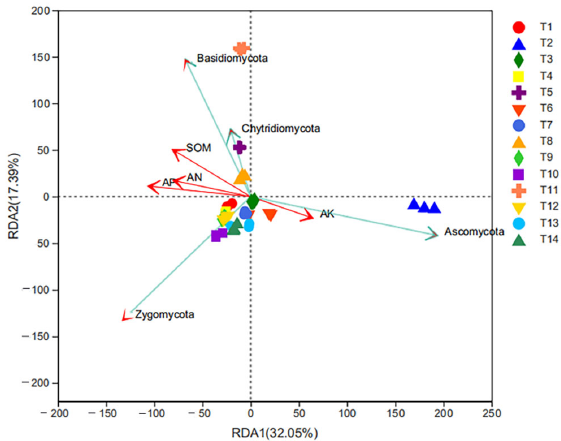
Figure 5. Correlation between fungal community composition and soil physical and chemical properties of soil samples from different aged apple orchards. SOM: soil organic matter; AN: soil available nitrogen; AP: soil available phosphorus; AK: soil available potassium. The values on axis 1 and axis 2 represent the percentage interpreted for each axis. The red arrow represents environmental factors, and the green arrow represents dominant bacteria. Patterns with different colors and shapes refer to soil samples from different aged apple orchards. T1: Gao Bao Village; T2: Lu Bai Village; T3: